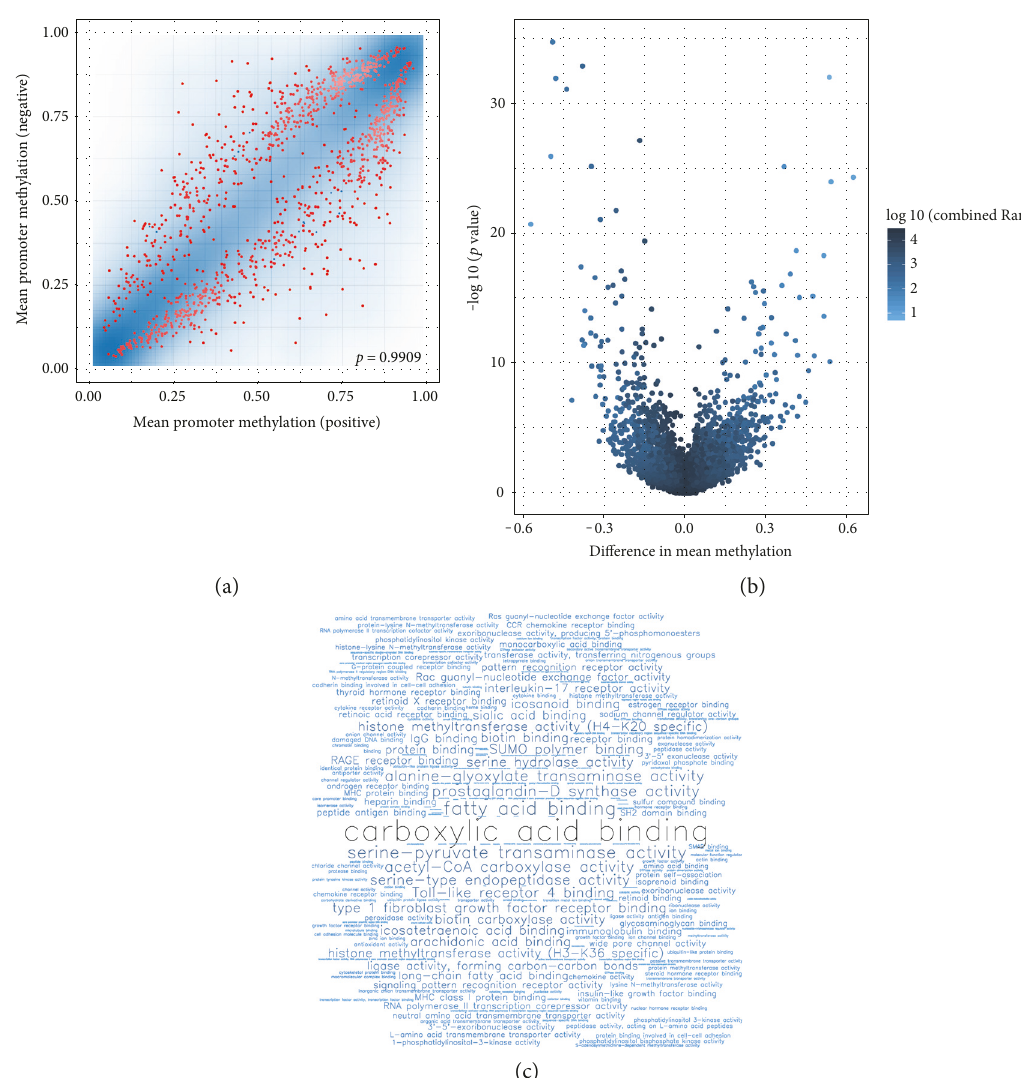
Figure 5: Di ff erential methylation of samples based on traits and GO enrichment. (a) Density plot of average promoter methylation in T (15; 17) positive ( x -axis) versus negative ( y -axis) patient groups. The density plot is overlaid with a scatter plot in which promoters with FDR-corrected p value < 0.05 are depicted as red points. (b) Volcano plot for T (15; 17) showing the relationship between di ff erences in group mean methylation and uncorrected p value for every gene promoter. (c) Word cloud showing the most enriched Gene Ontology terms in the category molecular function, when the top 100 hypomethylated gene promoters in the T (15; 17)-positive patient group are considered. Larger font size indicates a more signi fi cant p